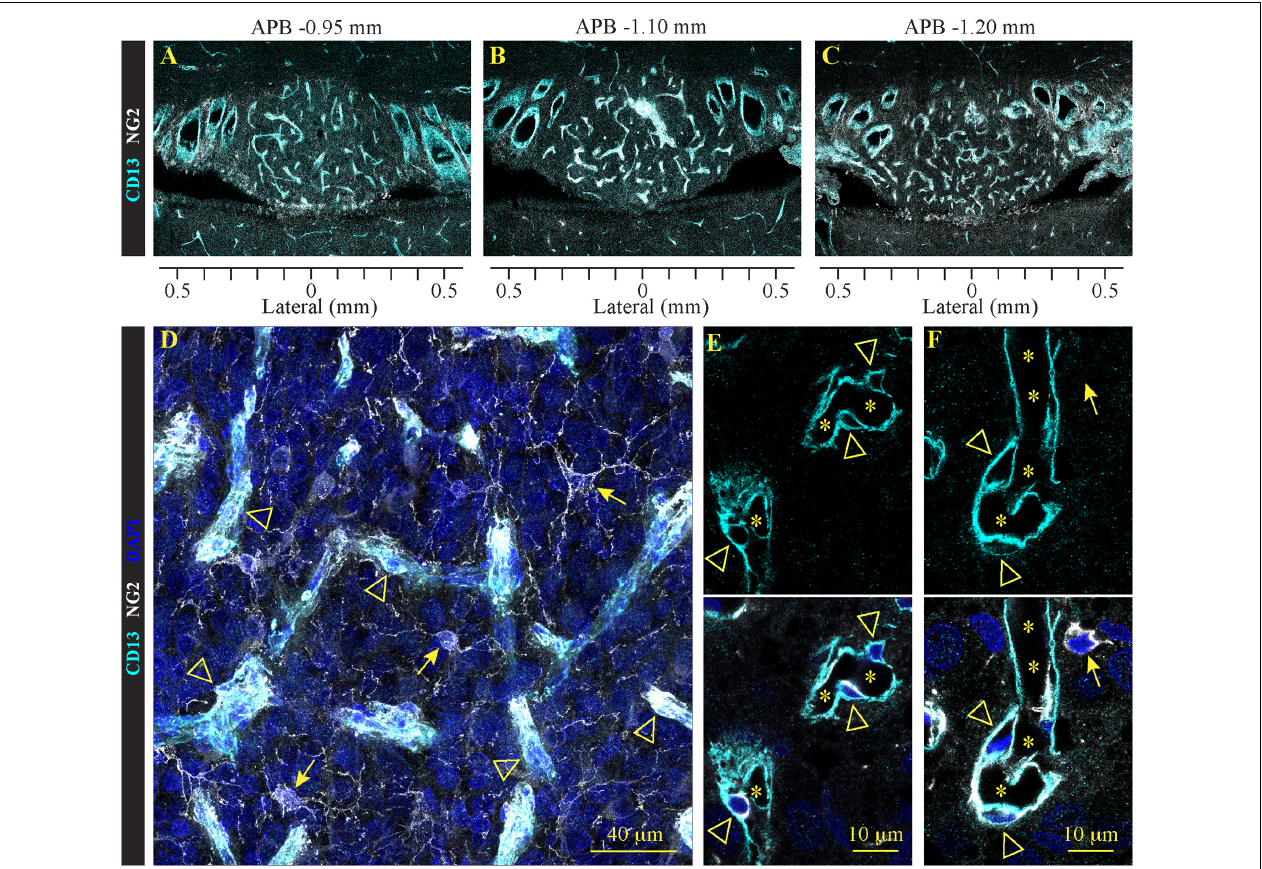
FIGURE 5 | Distribution of pericytes and NG2 glia in the SFO analyzed in the coronal plane. Immunohistochemical staining of pericytes and NG2 glial labeled with NG2 (white), pericyte-specific marker CD13 (cyan), and DAPI (blue) in serial coronal sections of SFO corresponding to APB coordinates –0.95, –1.10 and –1.20 mm